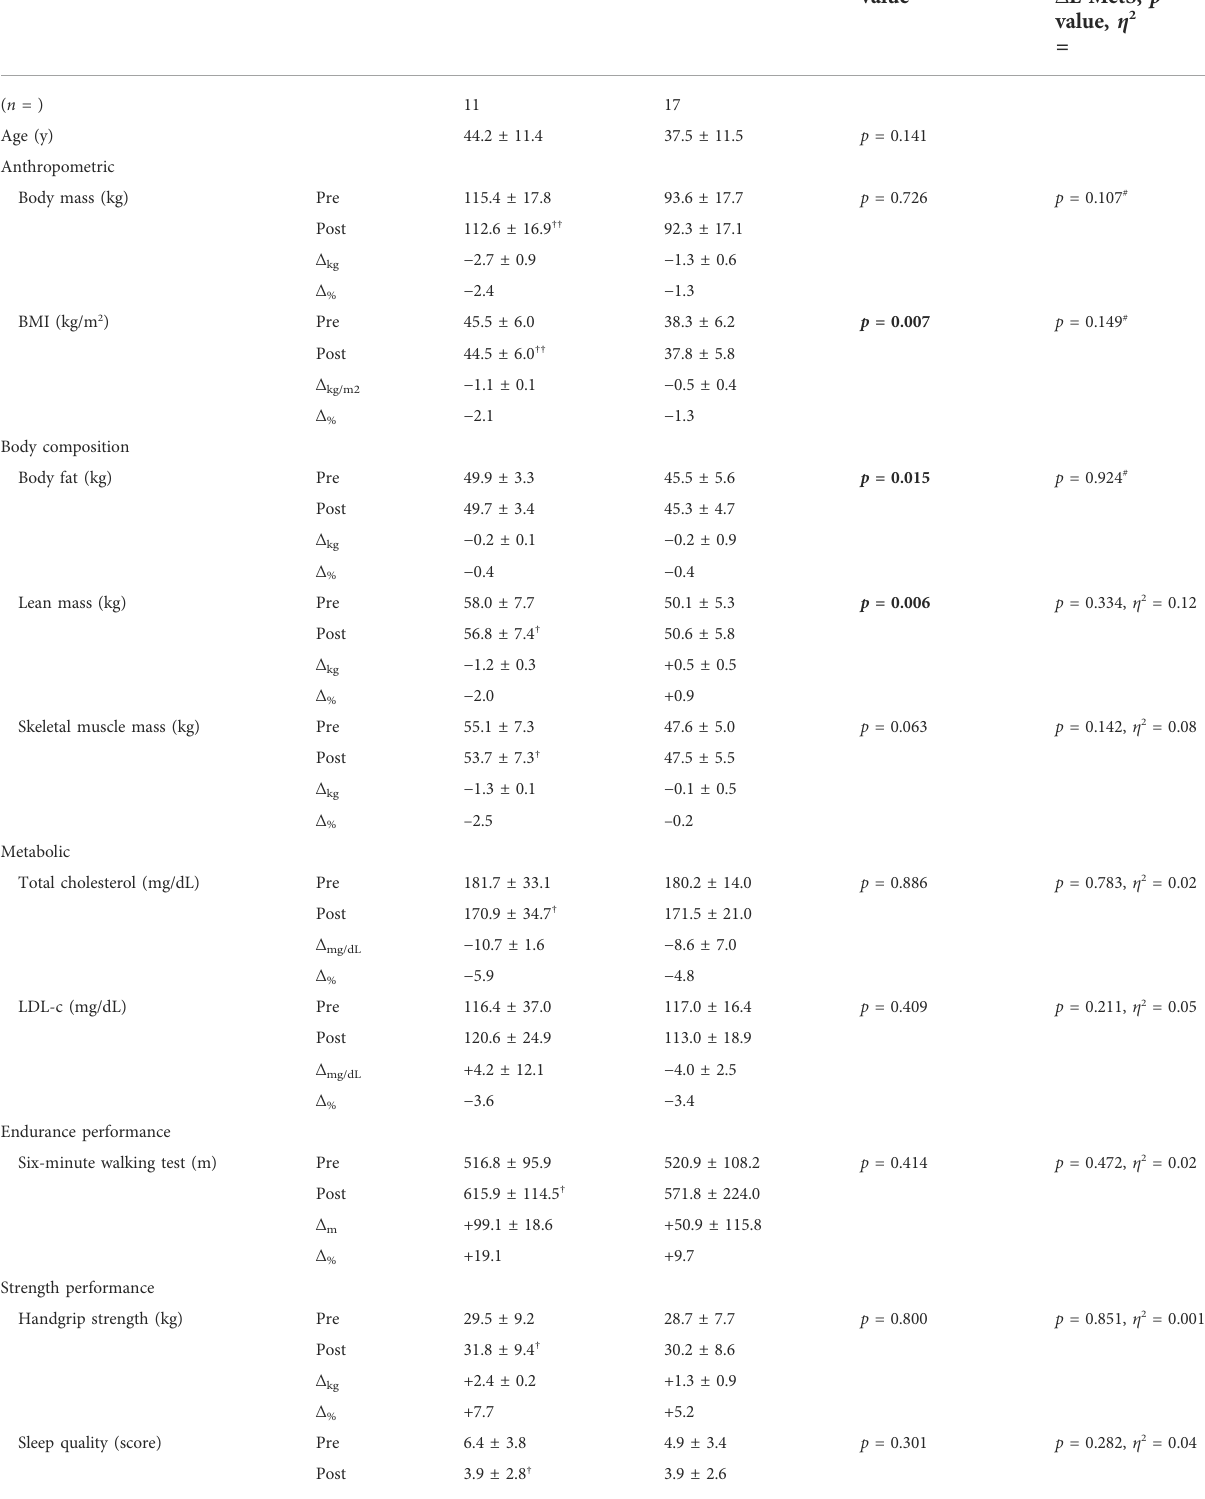
TABLE 1 Characteristics of the morbidly obesity with high and low loads of metabolic syndrome risk factors after 20 weeks of patient participants of two concurrent